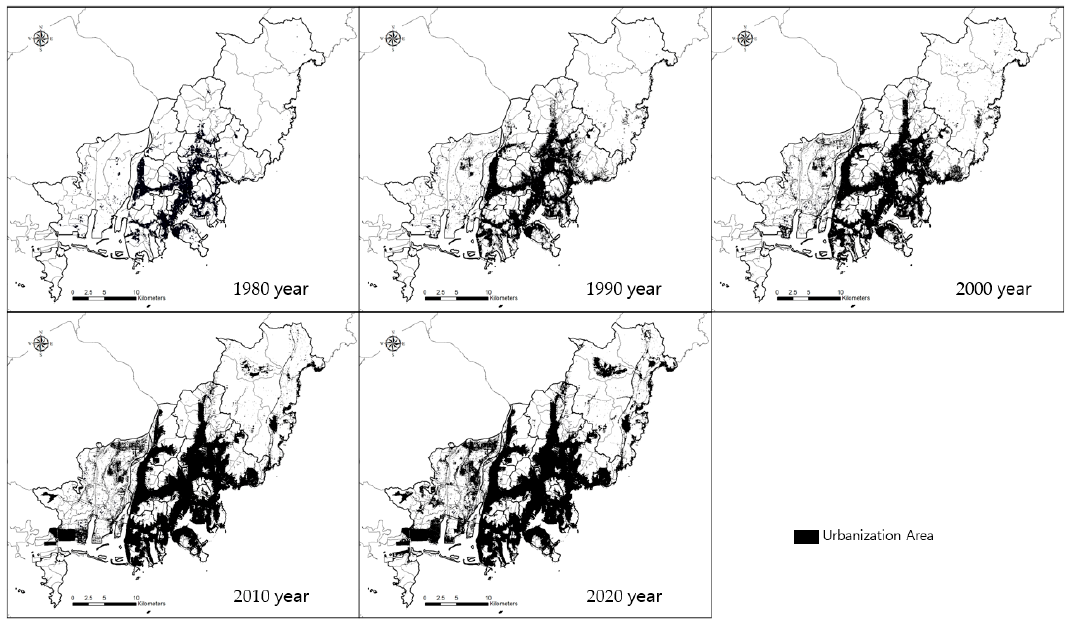
Figure 4. Changes in the urbanized area in BMC. Note: The base map was adopted from the National Spatial Data Infrastructure Portal of Korea (www.nsdi.go.kr (accessed on 12 August 2022)). Two facts can be identified by looking at the change in urbanized 30 m × 30 m area units shown in Table 3. First, the urbanized unit was continuously increasing at all times.